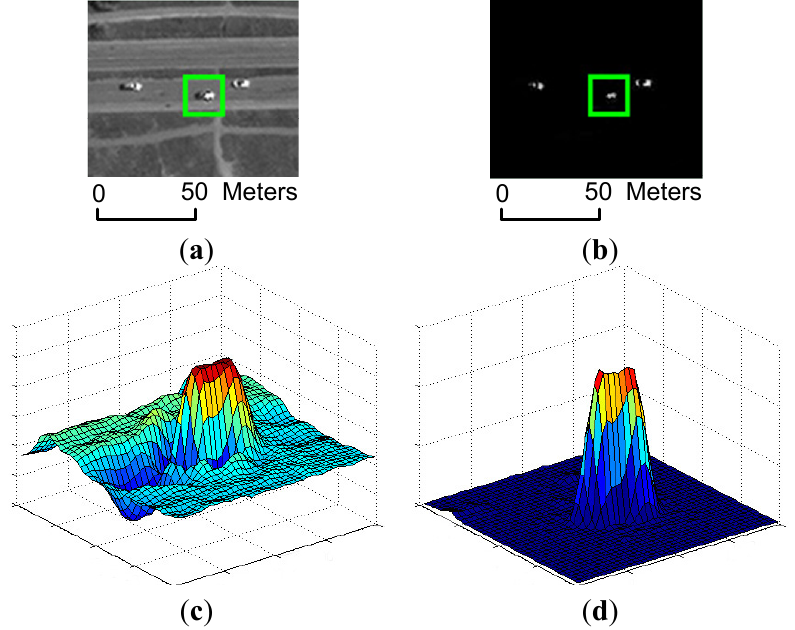
Figure 7. Vehicle (positive polarity) extraction results: ( a ) original image; ( b ) candidate location; ( c ) 3D distribution of vehicle and surroundings in the original image; ( d ) 3D distribution of vehicle and surroundings in the resulting image.